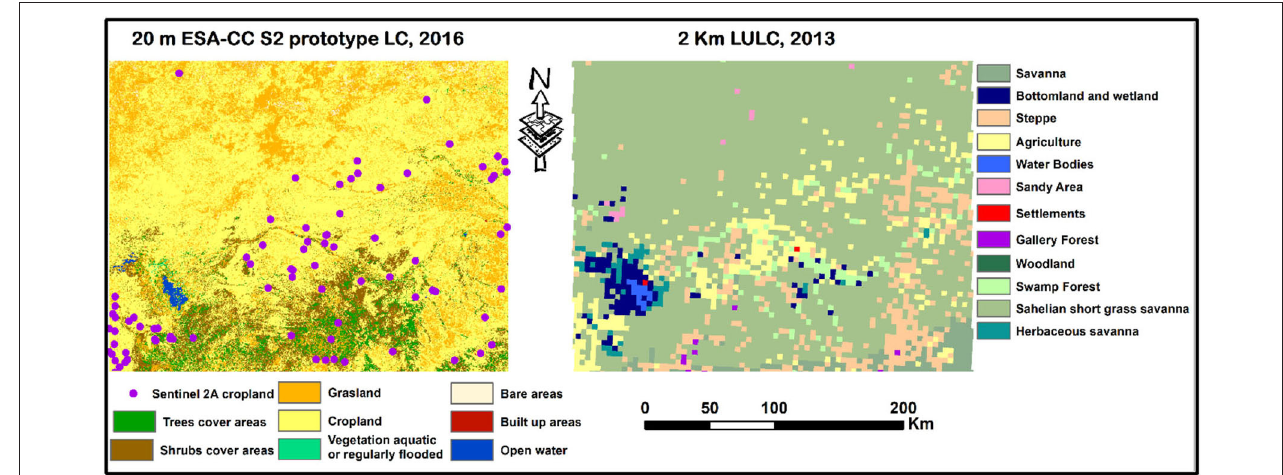
FIGURE 3 | Cropland in ESA-CCI S2 prototype LC (Left) , Sentinel 2A (pink dots), CILSS LULC (Right)